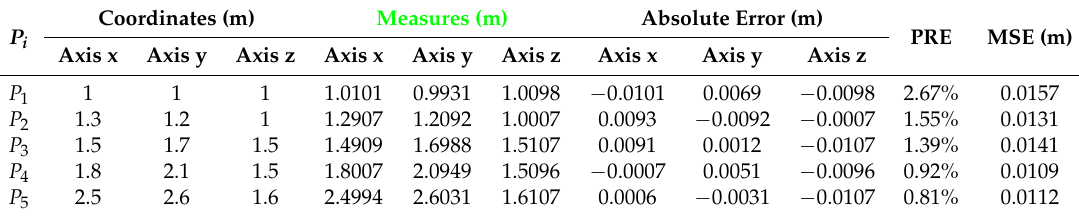
Figure 15. Picture of the acoustic receiver and the portable device where the positioning data are remotely acquired and shown. Table 1. Experimental measurements of test positions. PRE, Percent Relative Error.